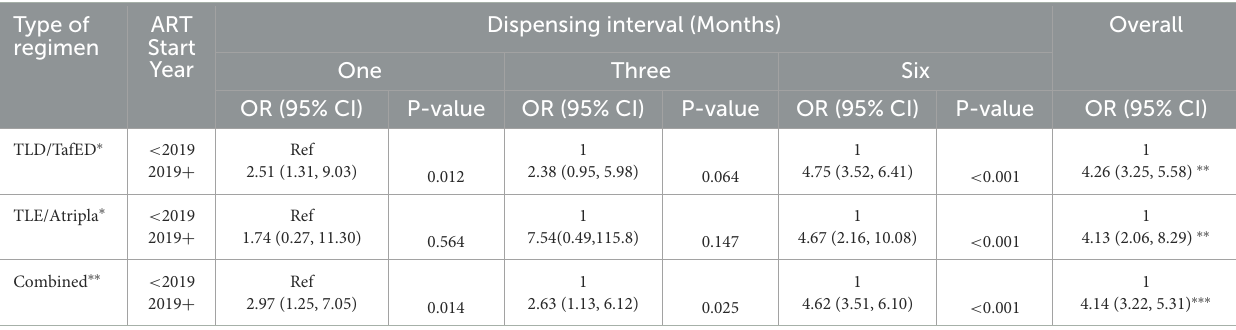
TABLE 3 Stratified and combined adjusted analysis to determine the impact of the COVID-19 pandemic on viral detectability (a measure of adherence to ART) using multivariable logistic regression. Type of